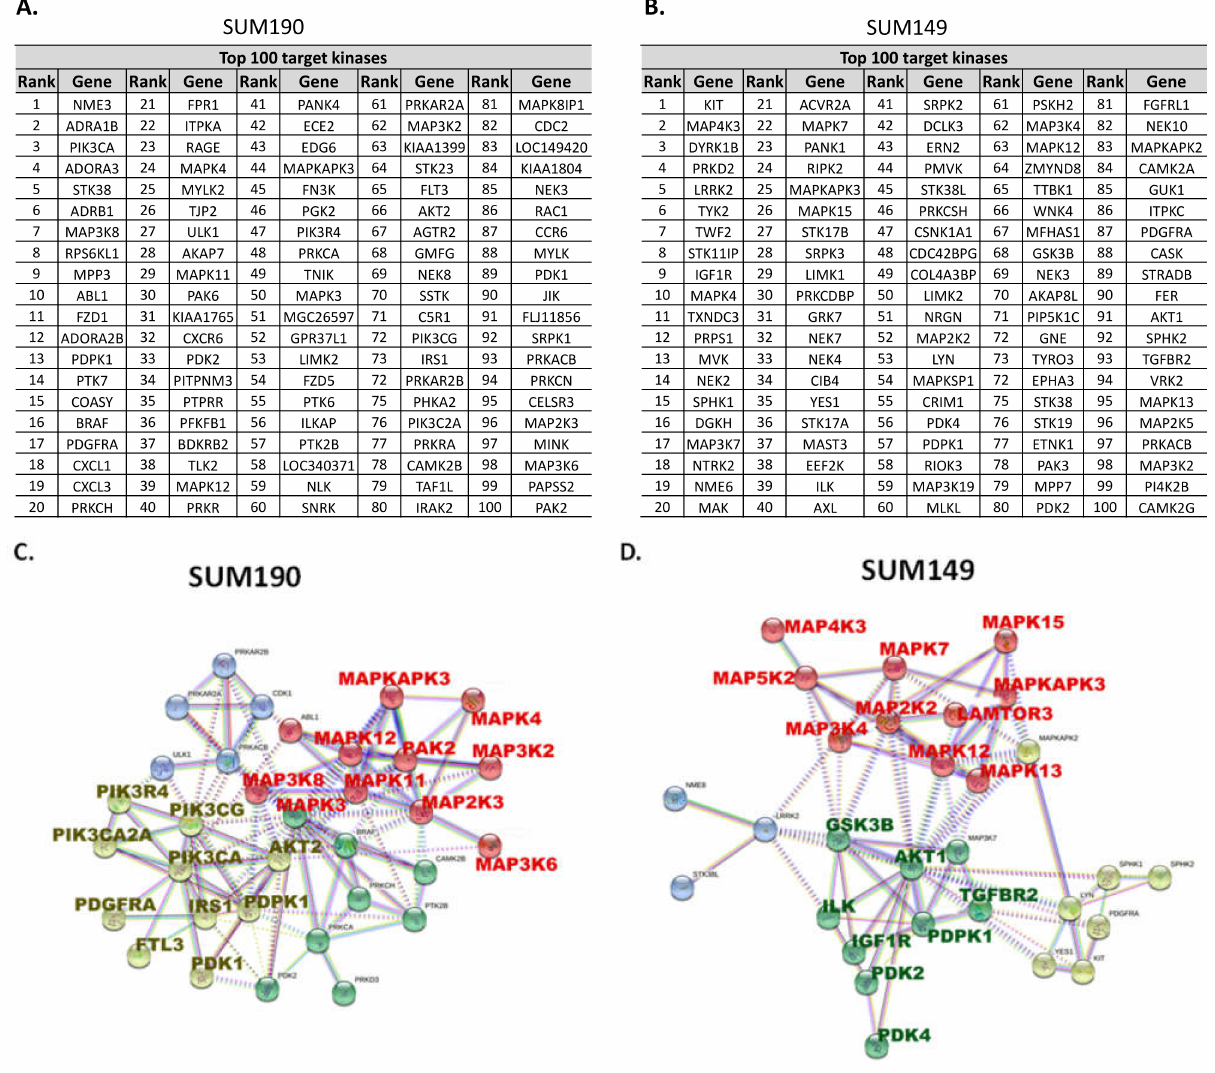
Figure 2. High-throughput siRNA library screening and protein-protein interaction analysis identified PI3K and MAPK pathways as potential candidates for combination with neratinib in TNBC and HER2+ breast cancer cell lines. ( A , B ). The top 100 target genes by sensitivity index analysis in SUM190 ( A ) and SUM149 ( B ) cells. ( C , D ). Canonical pathways identified by protein-protein interaction analysis and clustering (STRING V11) of SUM190 ( C ) and SUM149 ( D ) cells. Non-canonical target genes were excluded when exporting the